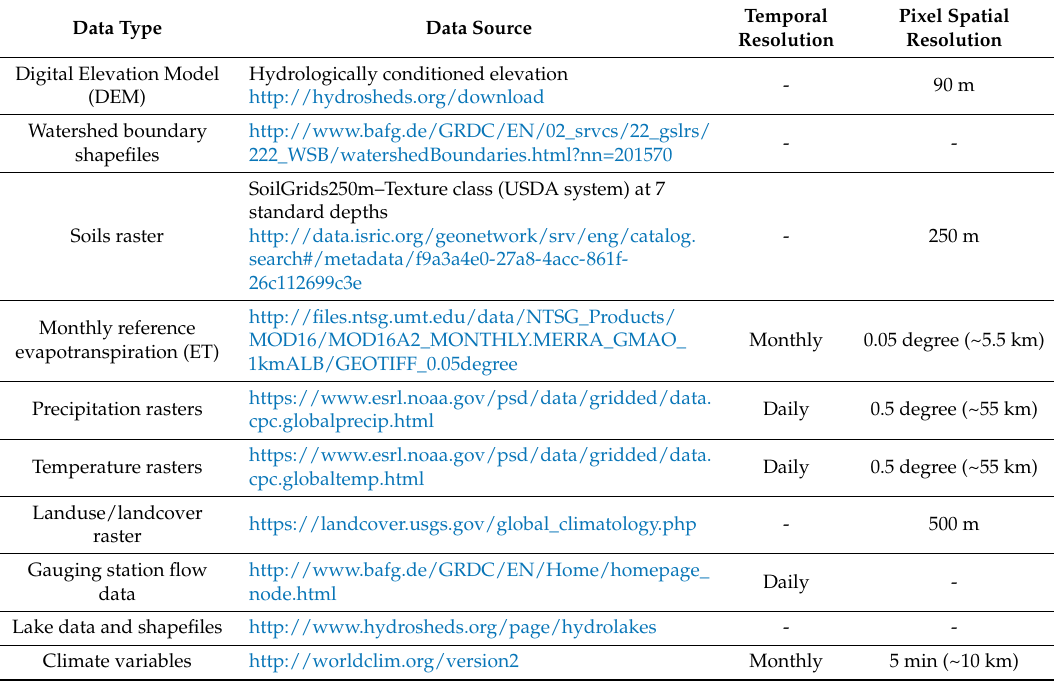
Table A1. Data types and sources required to run the InVEST